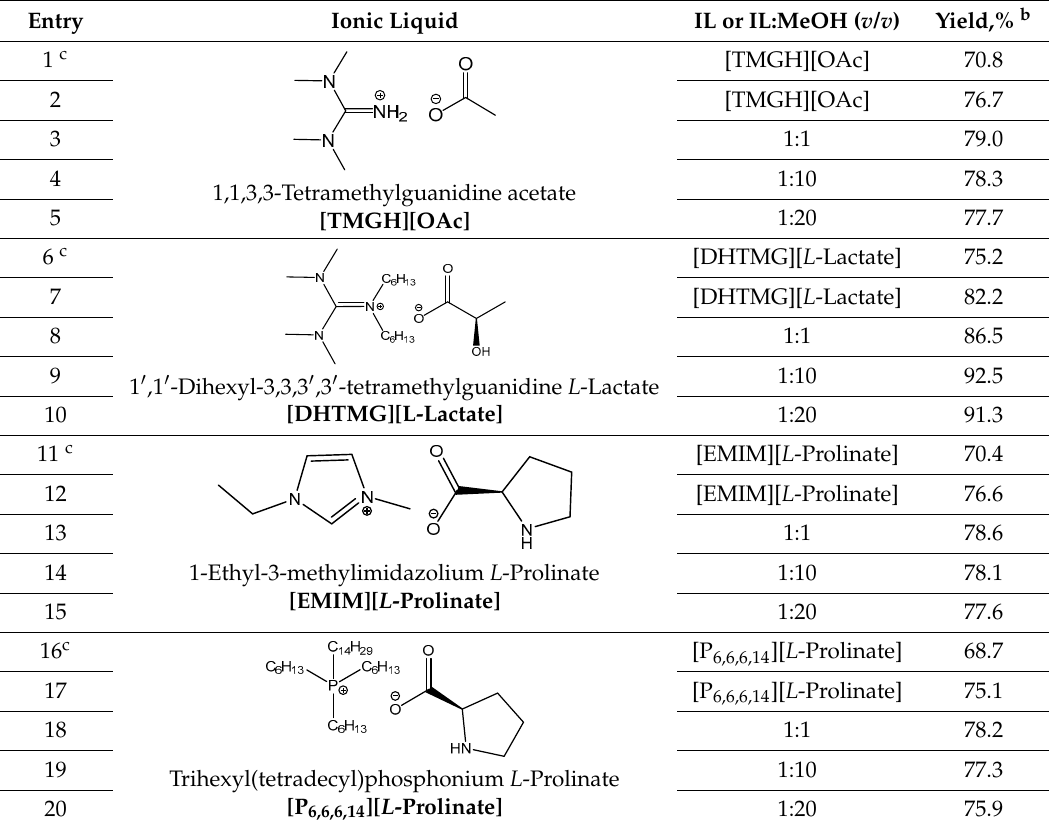
Table 4. Cyanosilylation of benzaldehyde with TMSCN in the absence or presence of catalyst 2 in IL or IL + MeOH media a .